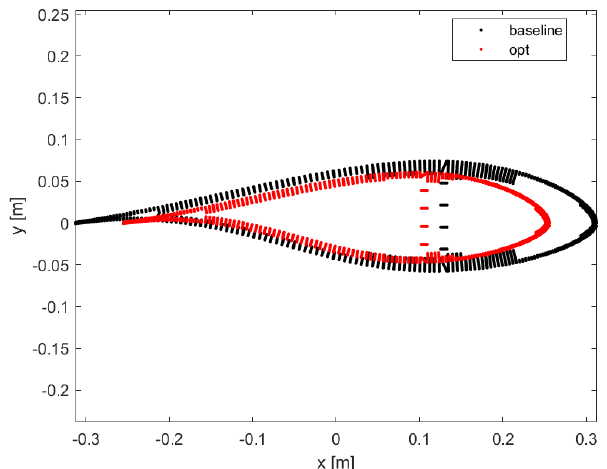
Figure 6. Internal structure of the mid-span section of the tip com- pared to the reference.